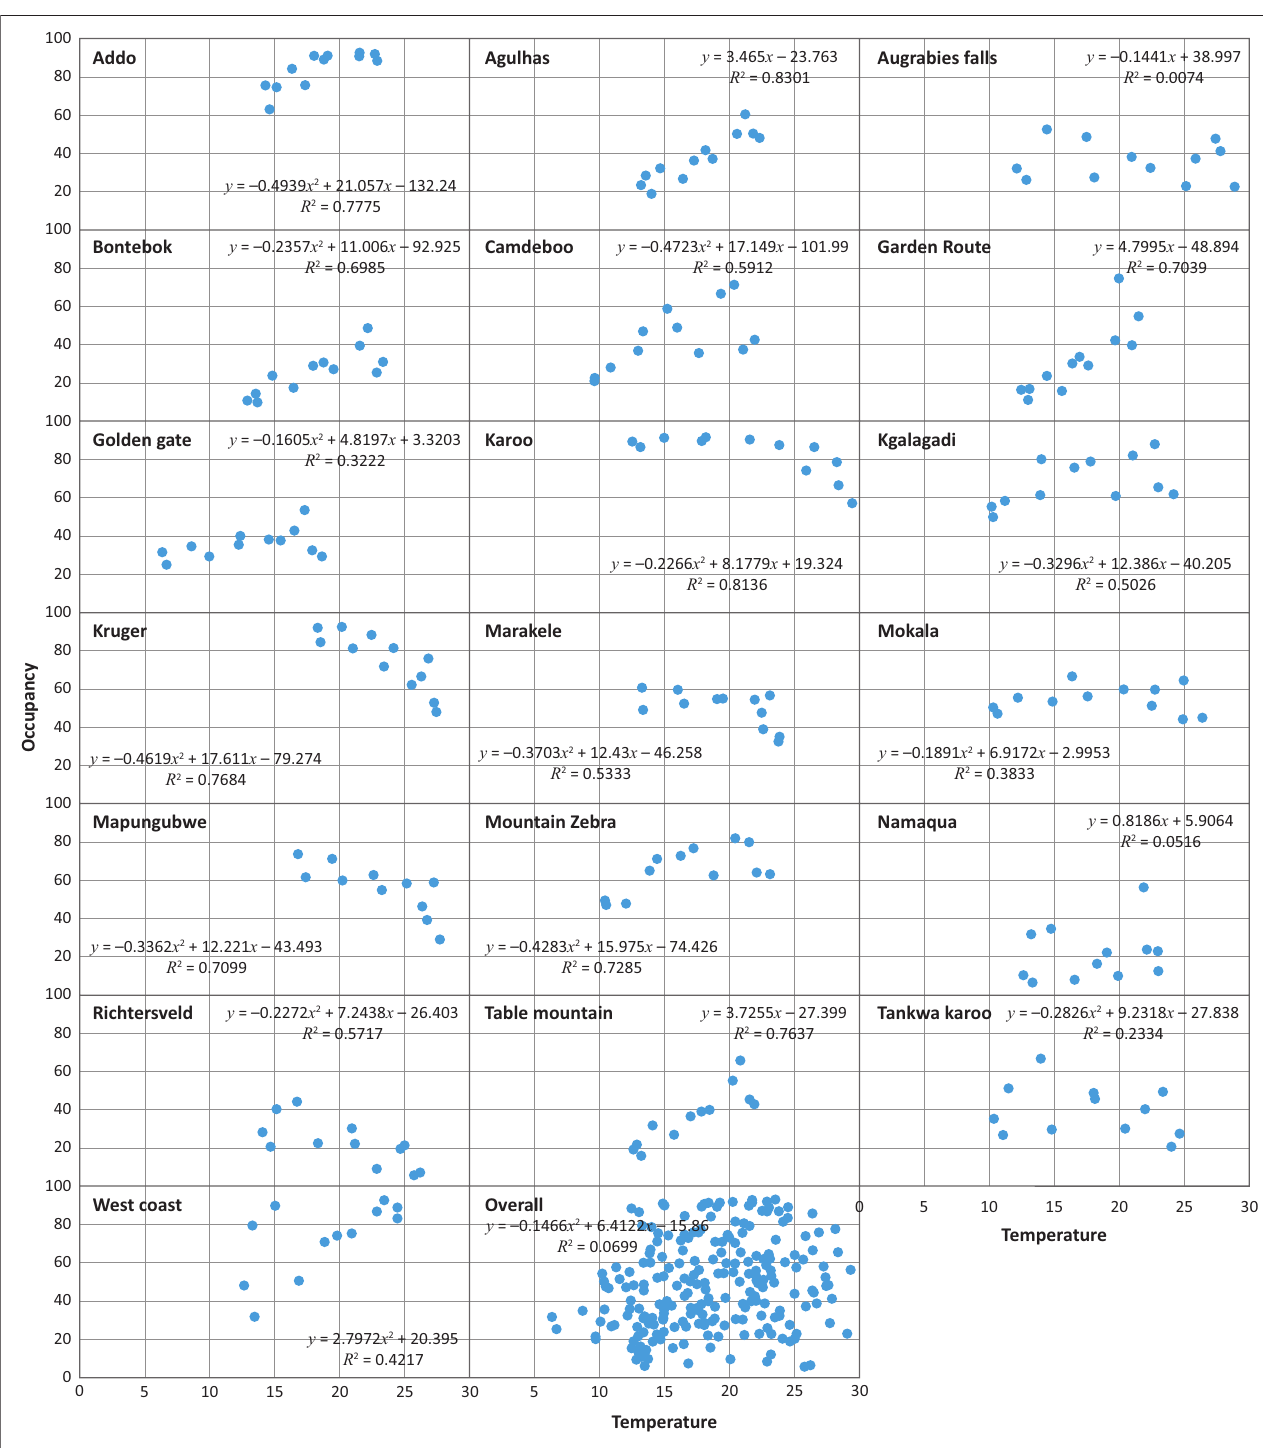
FIGURE 2: Relationship between mean monthly temperature (°C) and mean monthly percentage occupancy rate for each national park and overall. Parks are presented in alphabetical order.